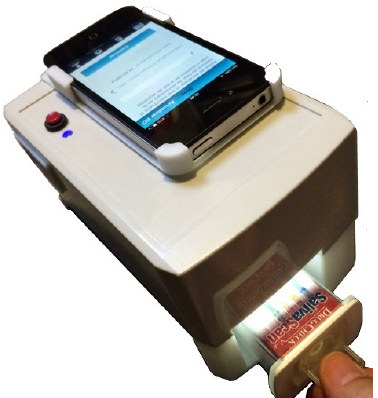
Figure 4. Light box with embedded electronic lighting system, which minimizes the relative movement between the smartphone and the test and the effects of external illumination